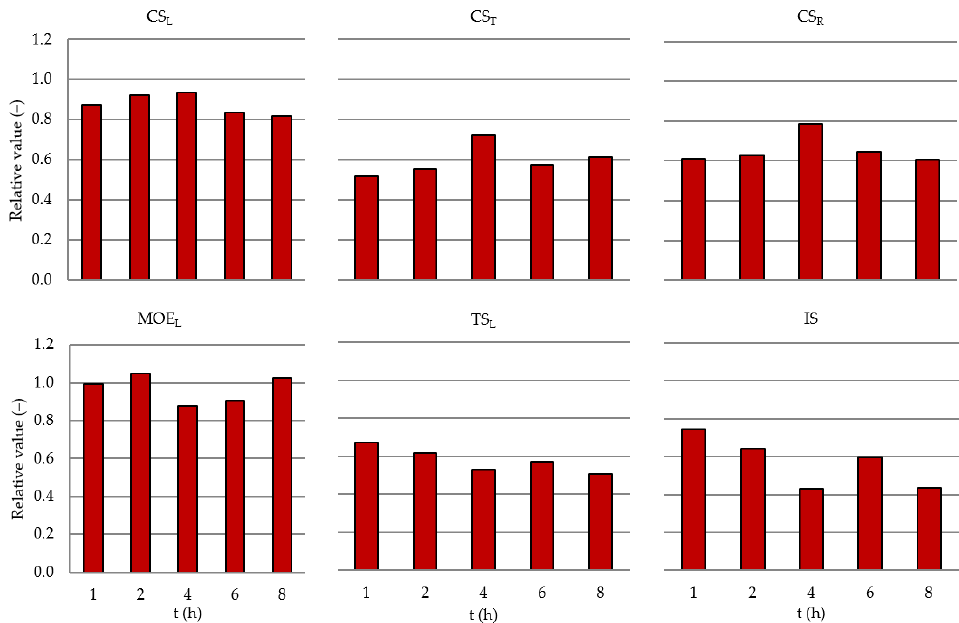
Figure 3. Relation to controlled value (in proportion) versus t (h). Each represents the mean value of n samples. IS, n = 20; CS L , n = 10; CS T , n = 10; CS R , n = 10; TS L , n = 10; MOE L , n =